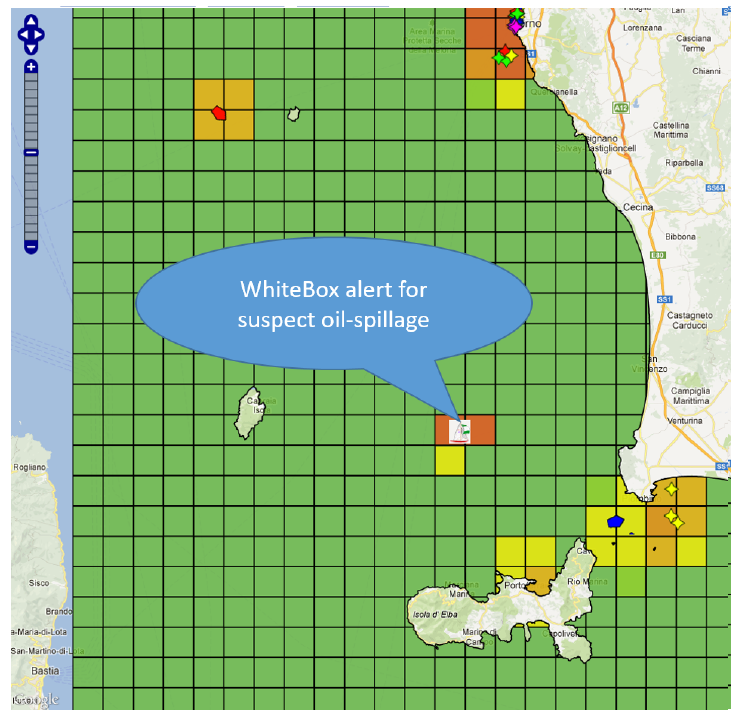
Figure 5. Marine Information System (MIS) interface showing dynamic risk map modification produced after reception of an alert from a